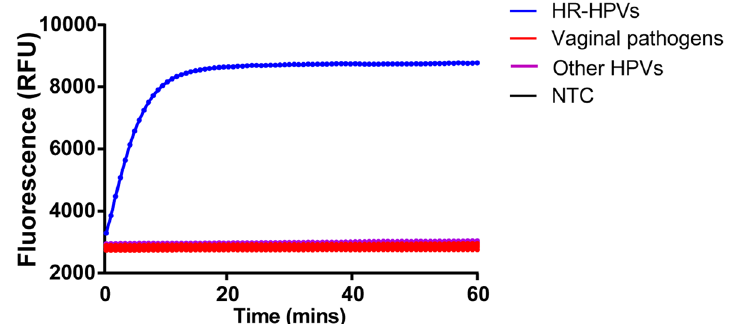
Figure 5. Specificity assessment of the RPA-CRISPR assay. Only DNA from the HR-HPVs produced signals, whereas plasmids from vaginal pathogens, other HPVs and the negative control did not produce any detected signals. The positive control was made by amplifying the HPV mixture where a total of 13 HR-HPVs were mixed at the concentration of 10,000 copies/μL for each type. NTC no-template